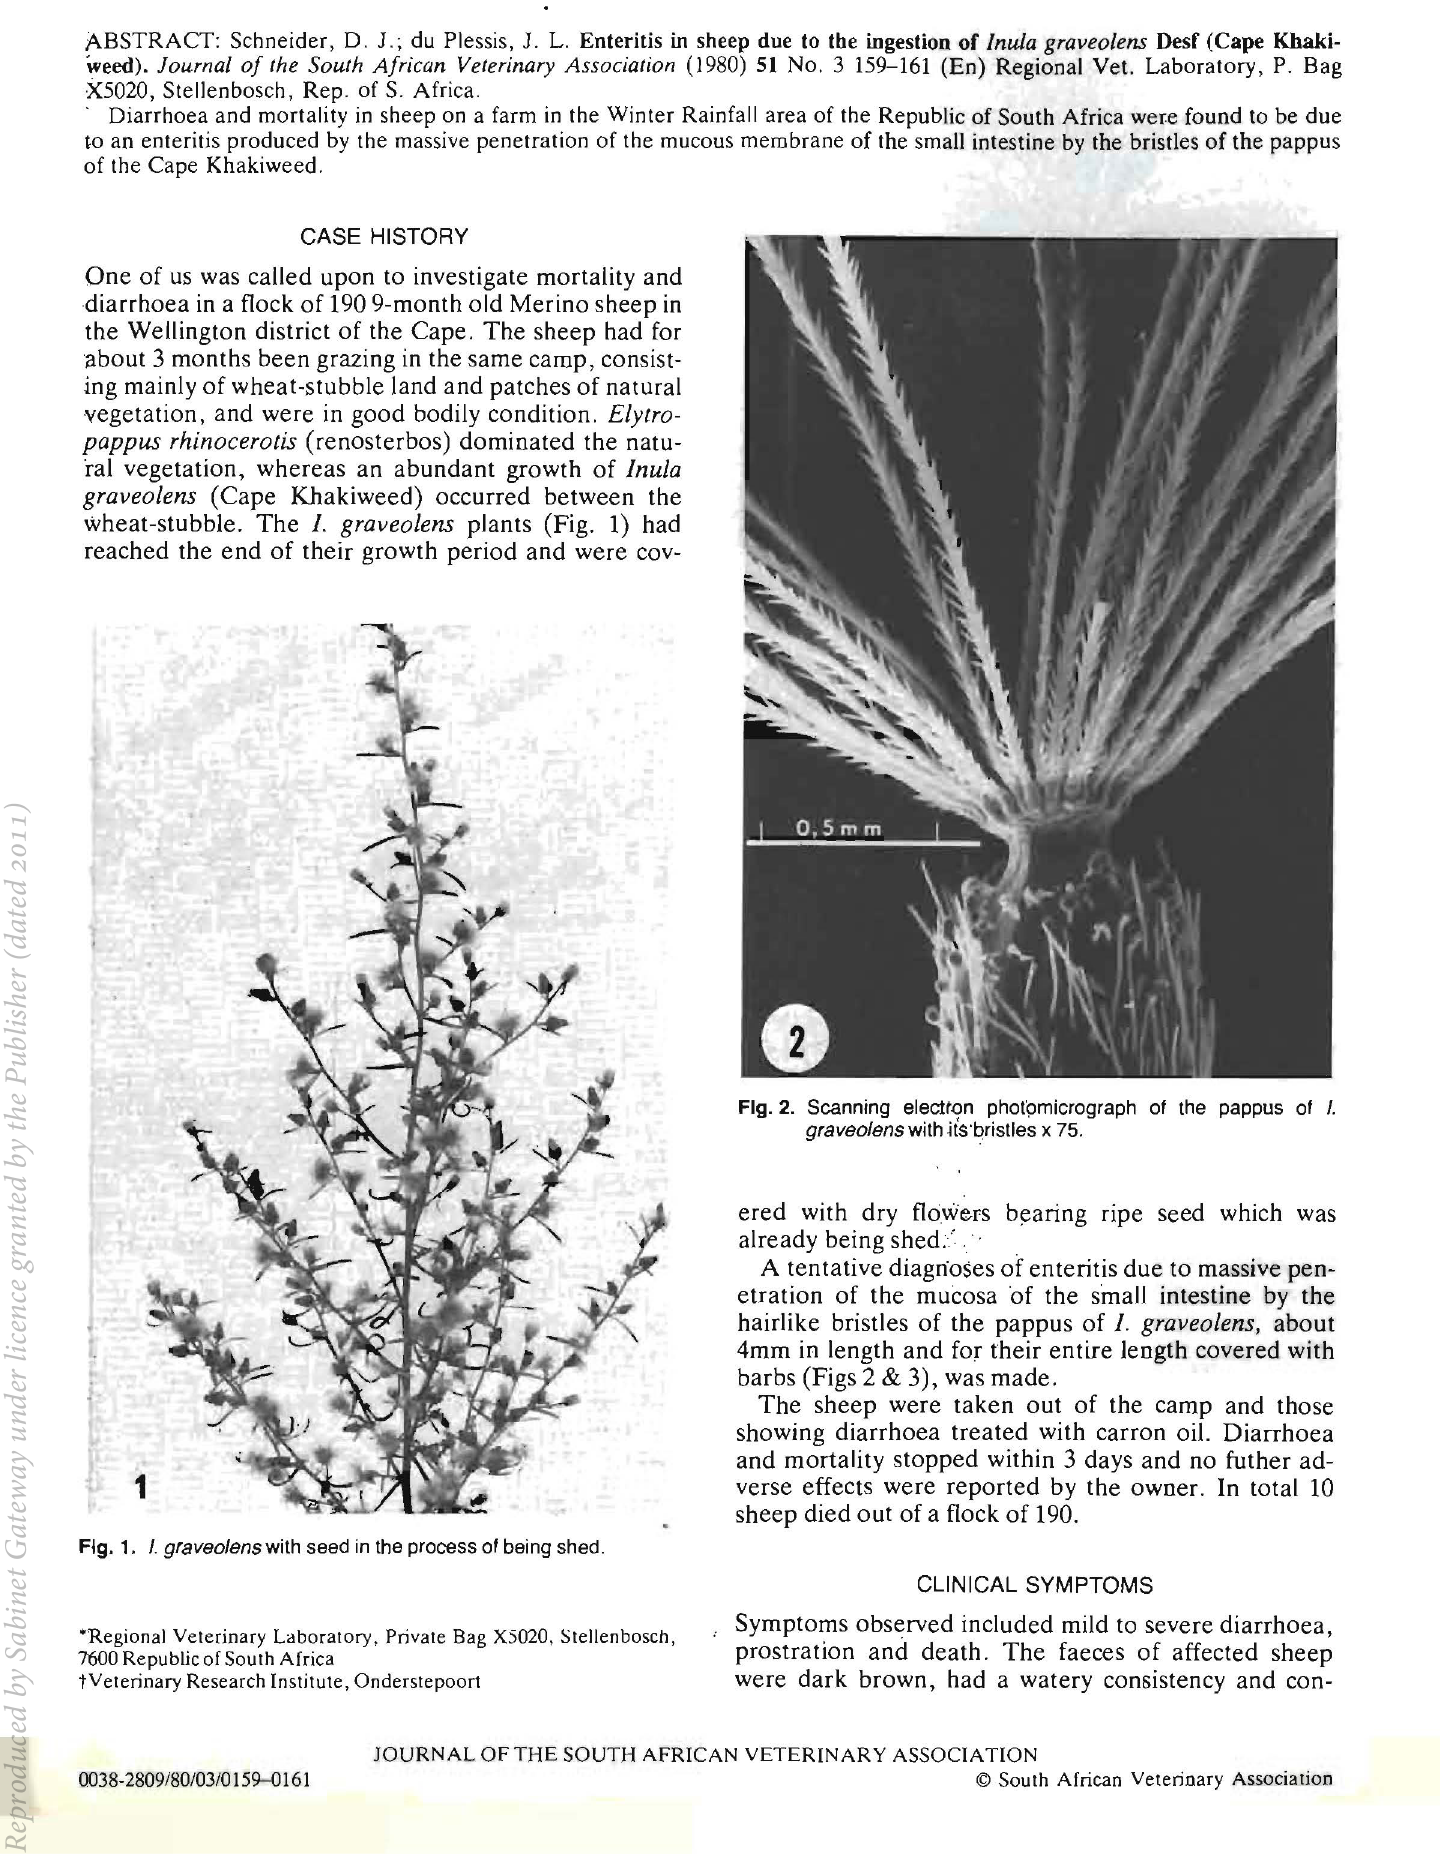
FIg. 1. /. graveo/enswith seed in the process 01 being shed.